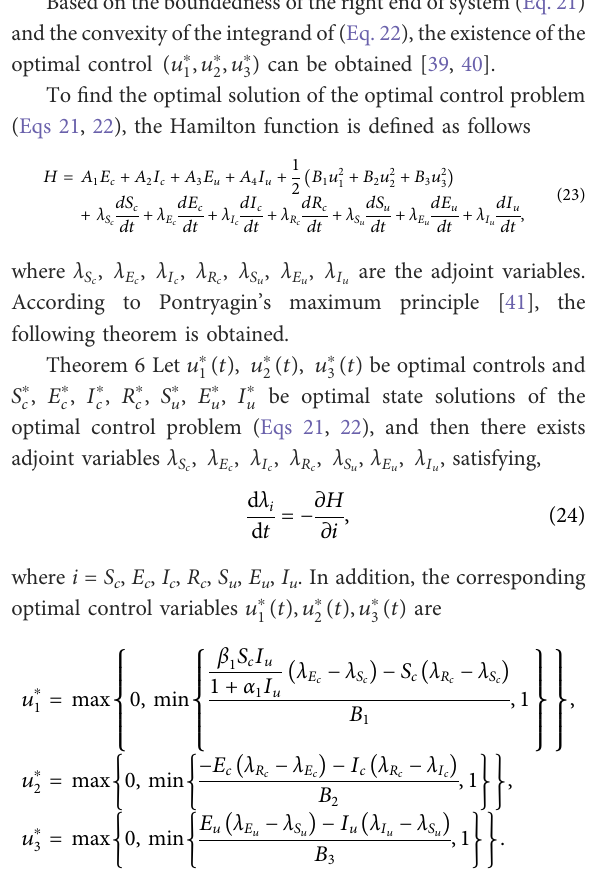
Three control variables u i ( t )( i (cid:2) 1 , 2 , 3 ) are introduced into system (Eq. 1), which denote the effectiveness of the corresponding control strategy to inhibit worm propagation.